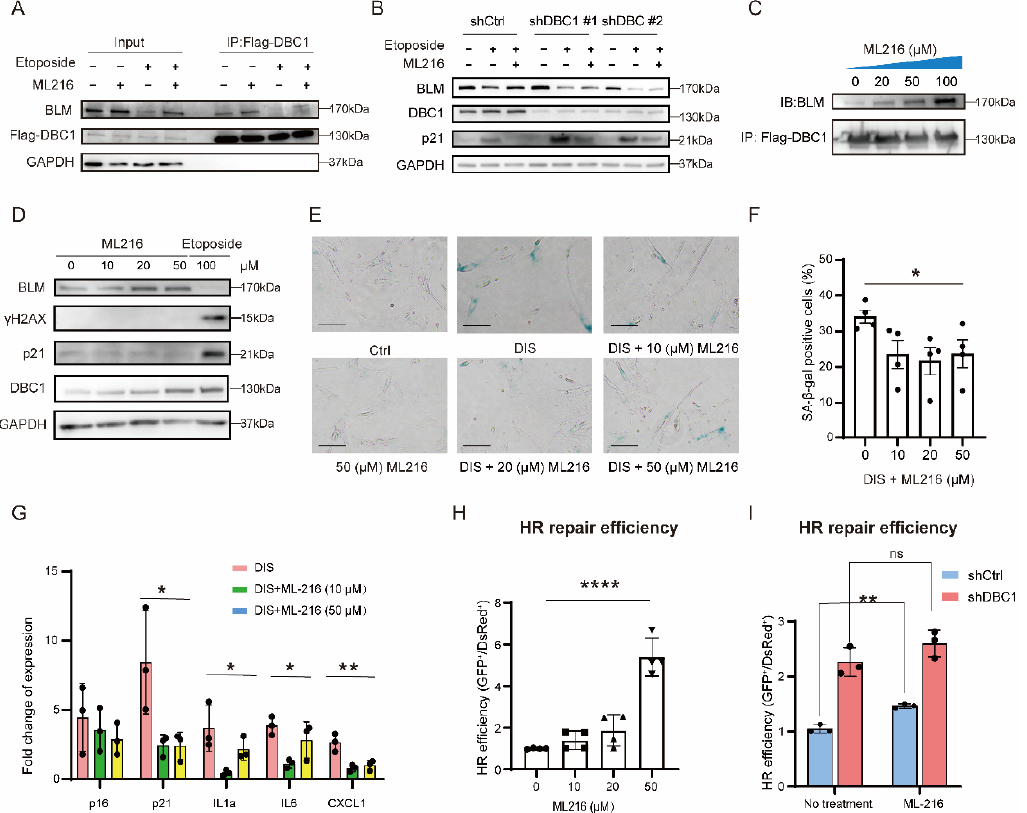
Figure 5. ML216 protects BLM from degradation by promoting DBC1–BLM interaction and sup- presses DNA damage-induced senescence. ( A ) Co-IP of Flag-DBC1 and BLM after the treatment with etoposide (100 μM), ML216 (50 μM) or both for 24 h. ( B ) Western blotting analysis of BLM and p21 protein levels in DBC1 knockdown cells treated with etoposide (100 μM), ML216 (50 μM) or both for 24 h. ( C ) In vitro immunoprecipitation of DBC1 with BLM in the presence of different con- centrations of ML216. Four equal aliquots of lysates from cells overexpressing Flag-DBC1 were in- cubated with 0, 20, 50, 100 μM of ML216 for 12 h, followed by immunoprecipitating DBC1 with Flag antibody and the detection of BLM using Western blotting. (see method 2.3 for the experiment pro- cedure). ( D ) Western blotting analysis of BLM, γ-H2AX and p21 protein levels in 293T cells treated with different concentrations of ML216 (24 h); etoposide was used as positive control for DNA dam- age (100 μM, 24 h). ( E , F ) Representative images and quantification of SA-β-gal-positive IMR-90 cells after DNA damage-induced senescence using etoposide or DMSO (see method 2.8 for the experi- ment procedure). Various concentrations of ML216 were added in cell culture with etoposide as a co-treatment. n = 4 biological replicates as indicated by the black dots, Kruskal–Wallis test. Scale bar = 100 μm. ( G ) Gene expression analysis of SASP-related genes p16, p21, IL-1α, IL-6 and CXCL-1 in the IMR-90 cells described in ( E ), measured by RT-PCR, one-way ANOVA test. ( H ) Homologous recombination (HR) repair efficiency of 293T cells treated with various concentrations of ML216 for 24 h, n = 4 biological replicates, one-way ANOVA test. ( I ) HR repair efficiency of DBC1 knockdown 293T cells treated with ML216 (50 μM, 24 h), n = 4 biological replicates. Data are presented as mean ± SD ( G,H,I ); Data are presented as mean ± SEM ( F ).